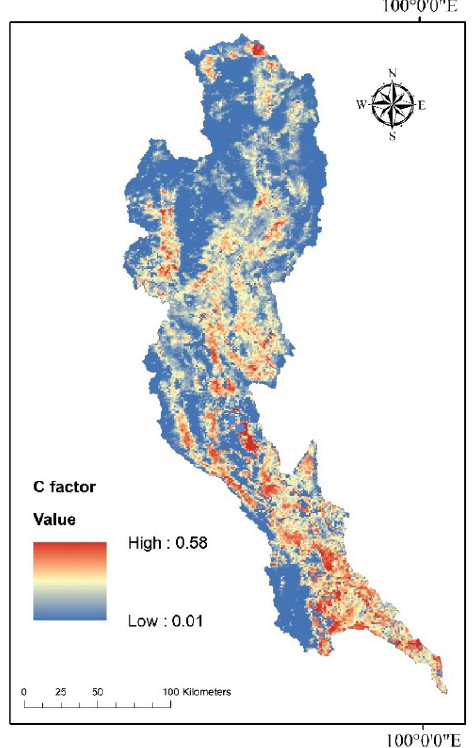
Figure 6. Topographic factor map.